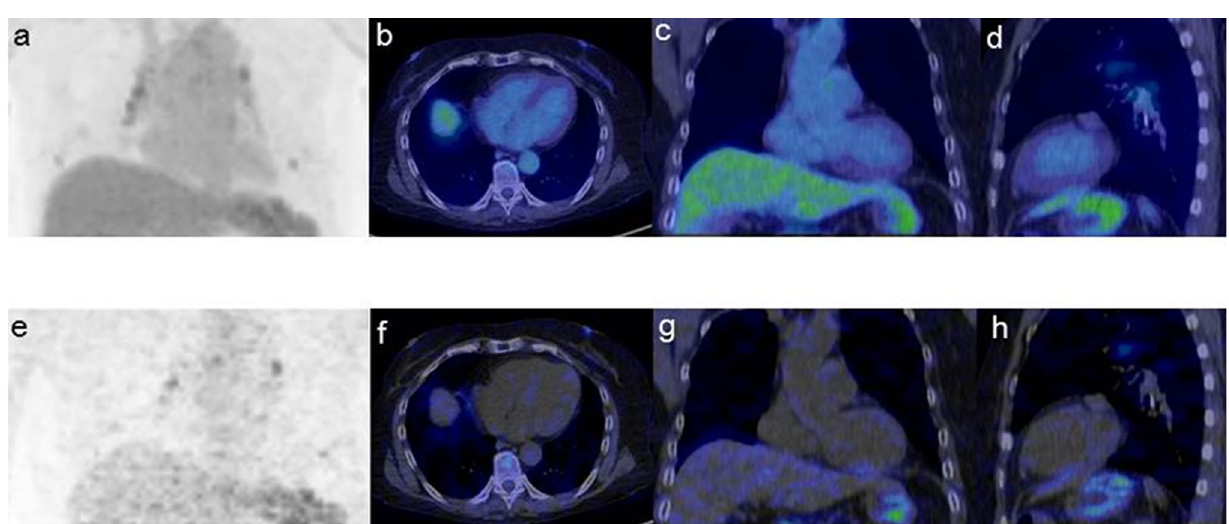
Figure 2. A 68-year-old male patient with CS who showed VT and cardiac dysfunction (EF: 25.3%) under steroid treatment (prednisolone, 10 mg daily). The SUV images [MIP ( a ), transaxial ( b ), coronal ( c ), and sagittal ( d )] and Ki images [MIP ( e ), transaxial ( f ), coronal ( g ), and sagittal ( h )] both show the positive myocardium for which the VOIs were automatically determined. The Ki volume (43.3 cm 3 ) was the only parameter positive for the risk of arrhythmic events according to each threshold criterion.